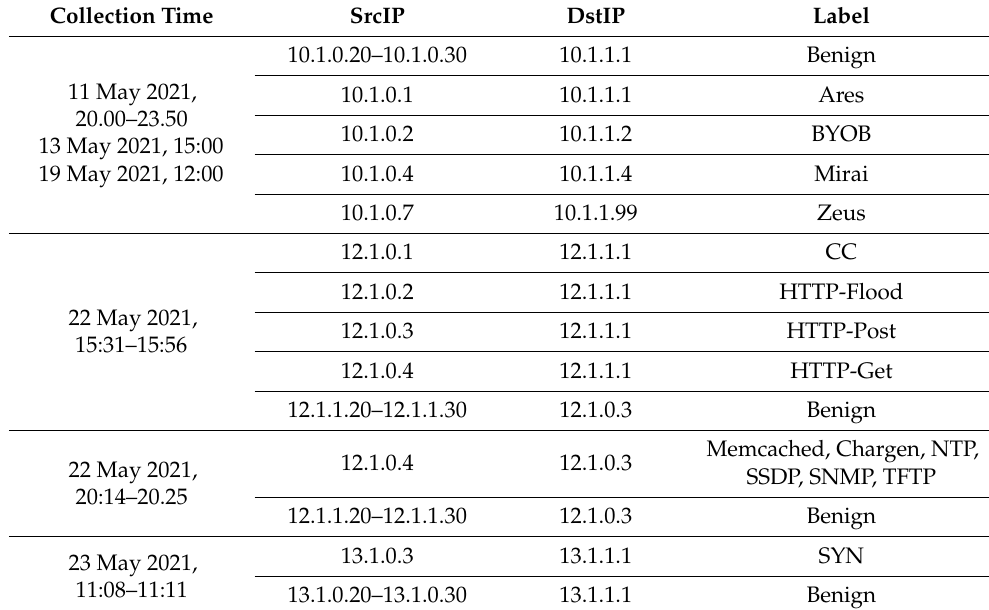
Table 2. DDoS datasets